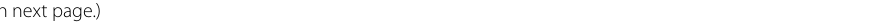
test. d The effects of circPTK2 and miR-181c-5p on hippocampal cell apoptosis was determined by TUNEL. N Sham; ^^^ P < 0.001 vs.